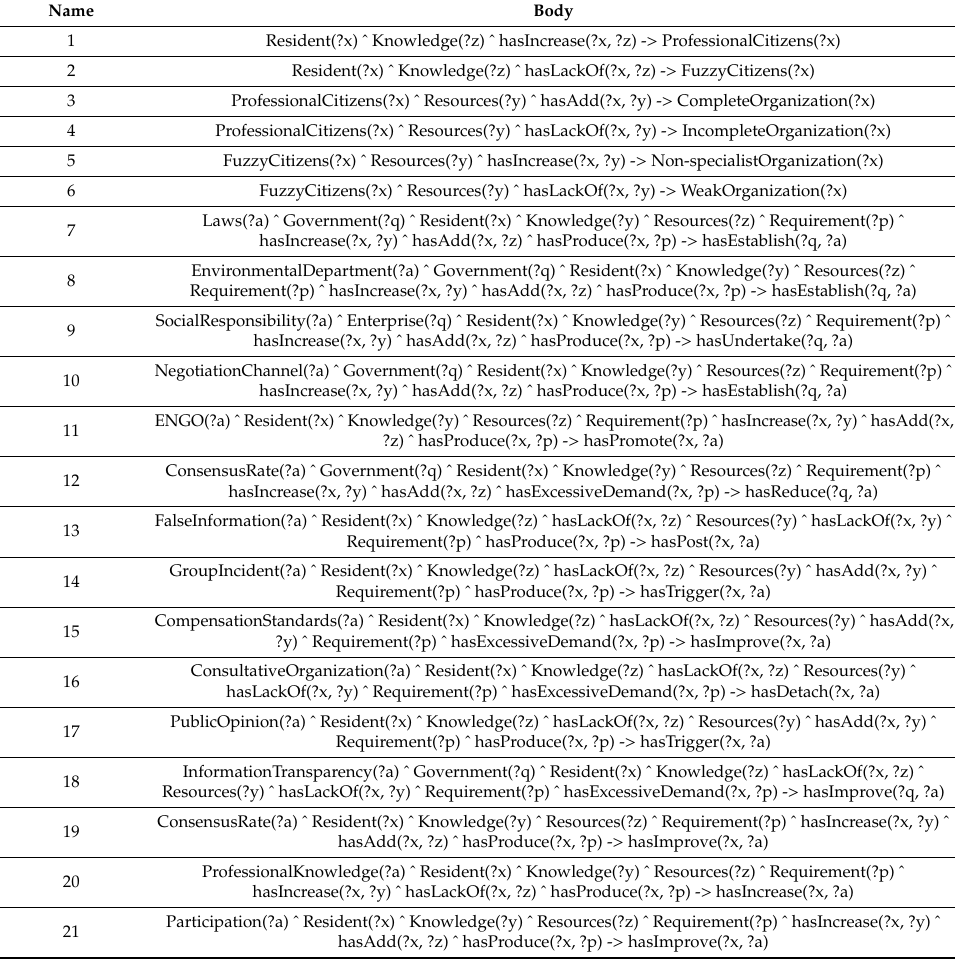
Table 2. SWRL-based rule